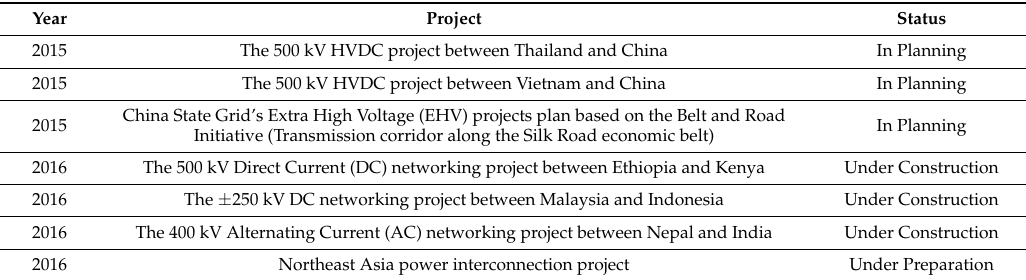
Table 1. Transnational networking projects in recent